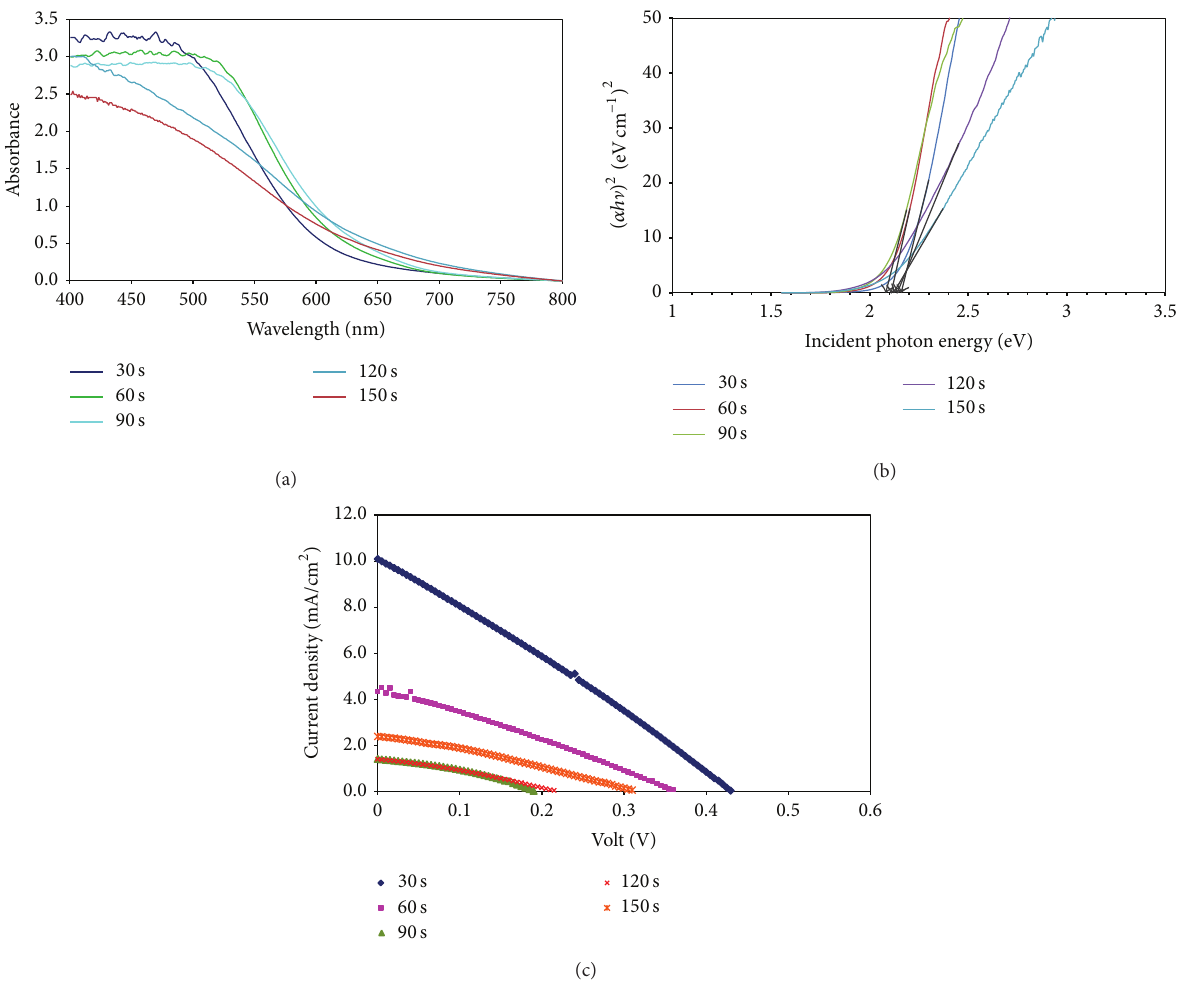
Figure 7: (a) UV-vis spectra, (b) Tauc plot, and (c) J-V curves of QDSSCs for CdSe QDs prepared using different dipping times.